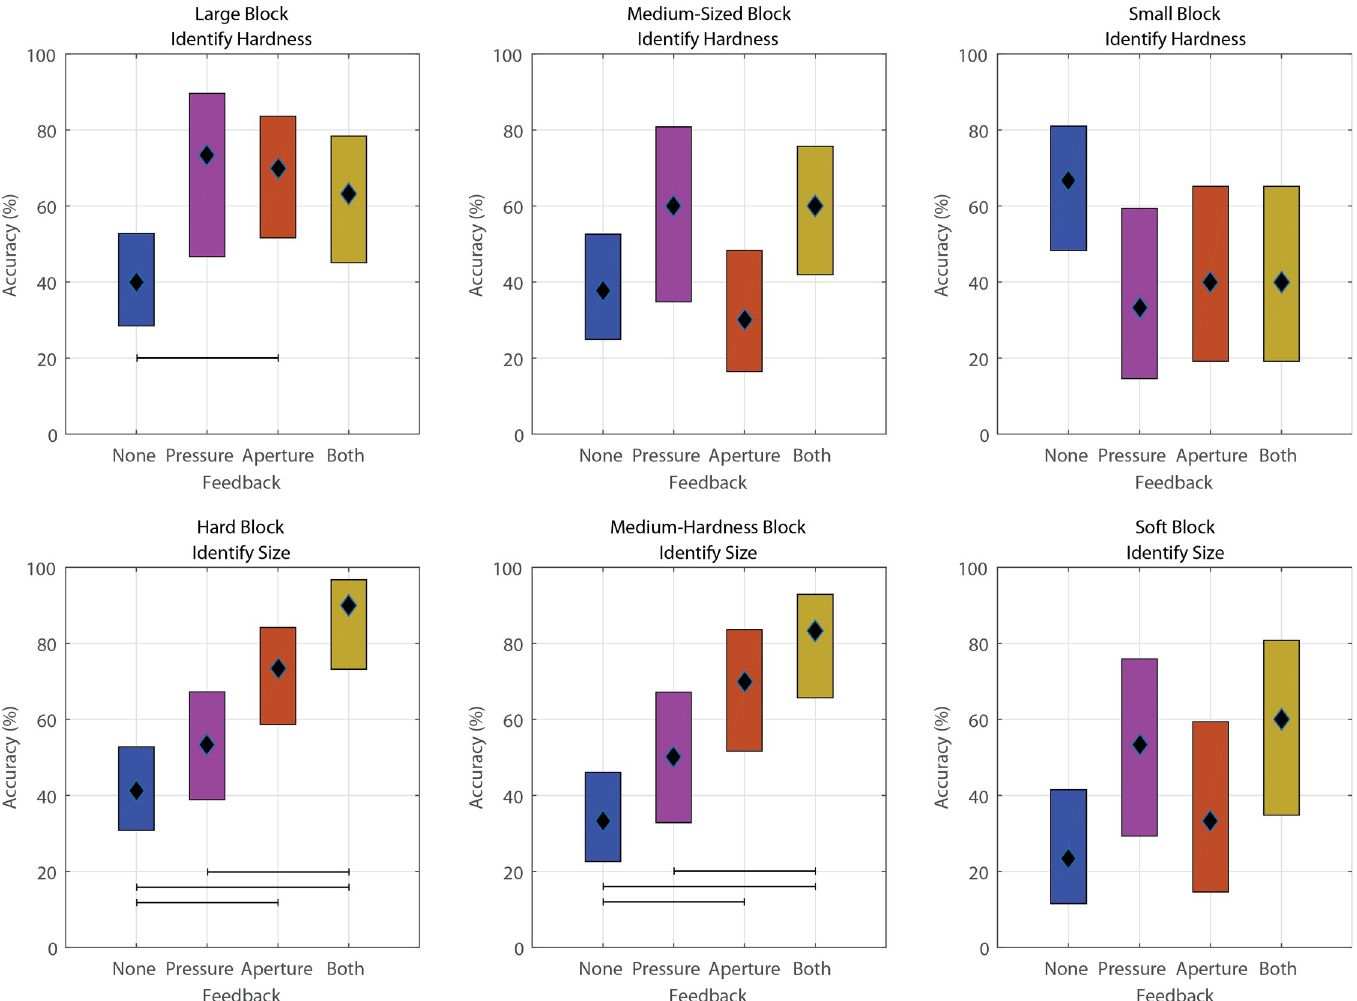
Fig 3. 95% confidence interval of the accuracy of block identification for S1. Black diamond denotes the mean. Observations that are significantly different (ANOVA with multiple comparison correction; p < 0.05) are distinguished with horizontal bars. In general, S1 performed best when sensory feedback was provided, but the best form of feedback depended on the block identification task. Averaged across all blocks in a particular identification task. Number of observations included in each panel are: top row (left-to-right): 135, 120, 75; bottom row (left-to-right): 195, 150, 75.